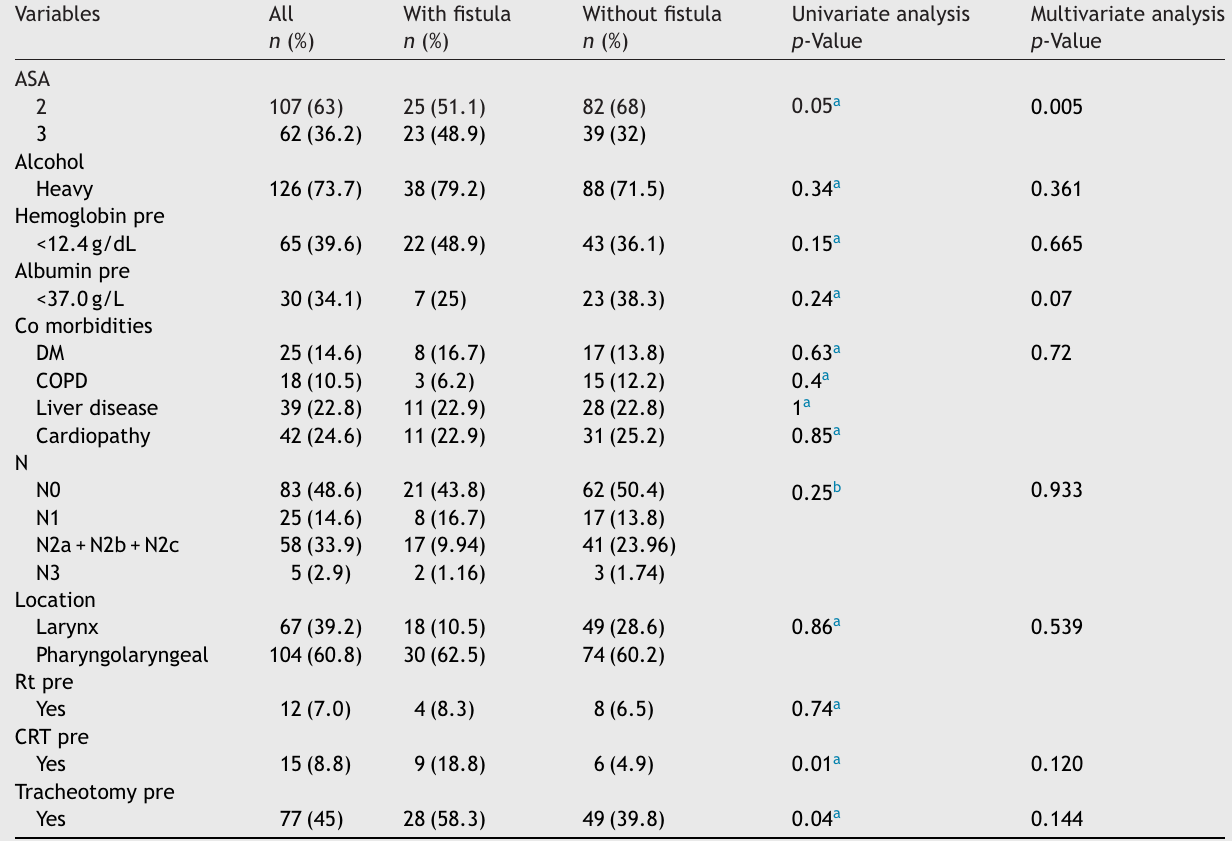
Univariate and multivariate analysis of the relationship between the variables included in the clinical decision rule and the frequency of pharyngocutaneous fistula.